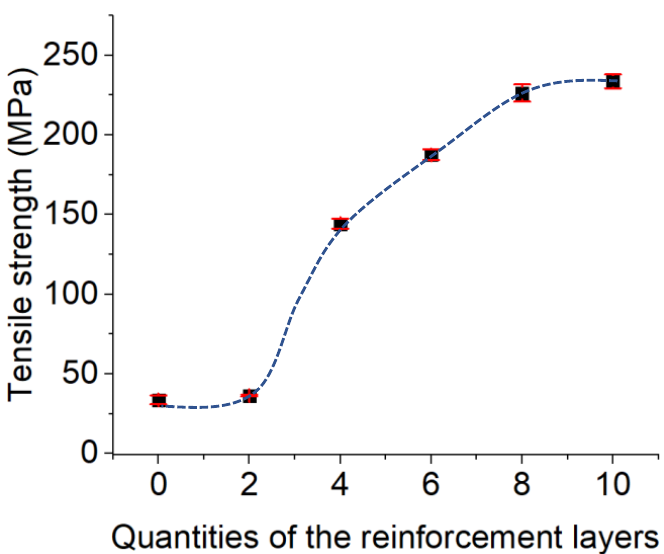
Figure 16. Effect of the density of the continuous reinforcement layers on the tensile strength.